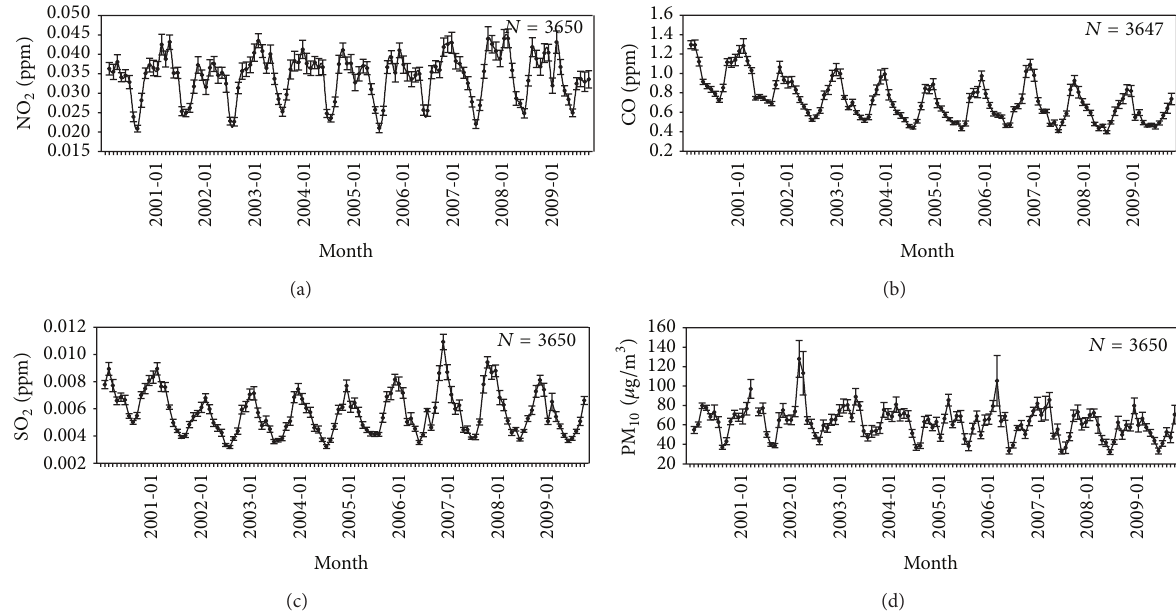
Figure 6: Monthly mean variations of (a) NO 2 , (b) CO, (c) SO 2 , and (d) PM 10 between 2000 and